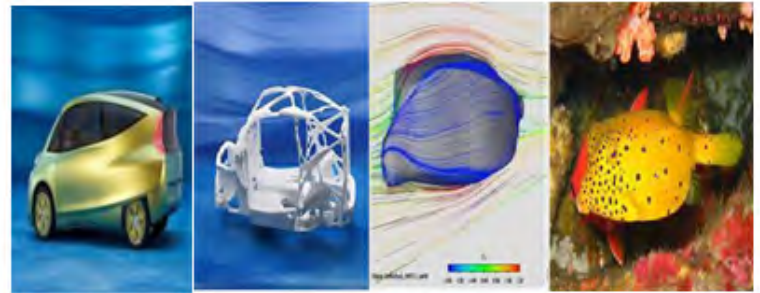
Figure 4. Daimler Crysler car design inspired by the shape of a fish and the way trees grow. Source: (Kibert,